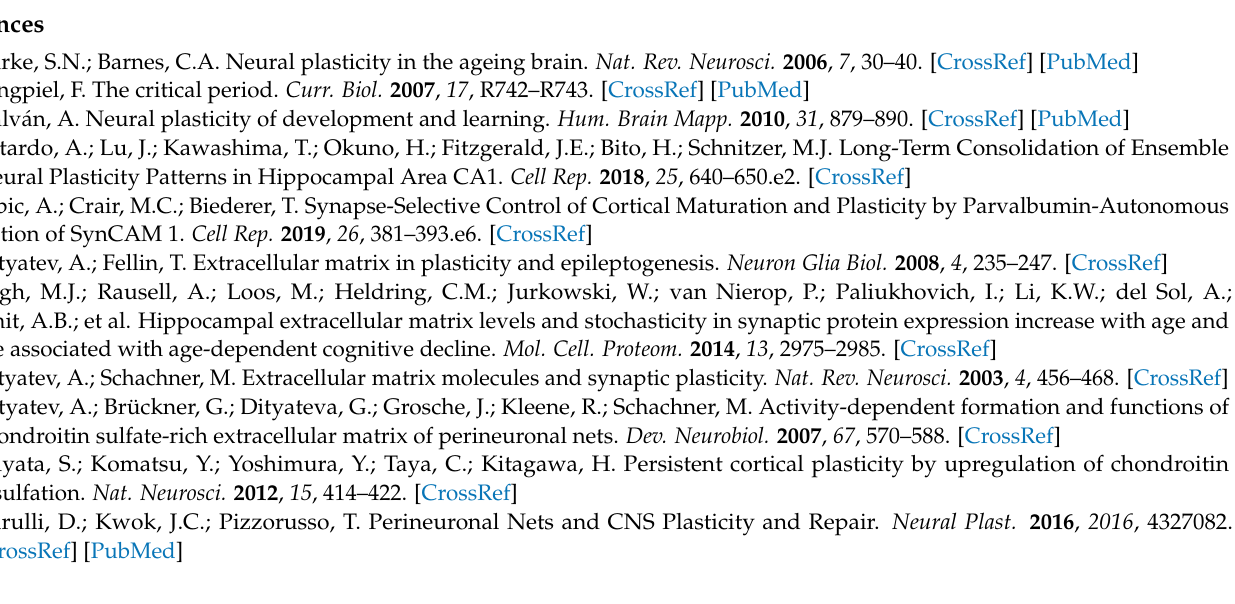
Table S2. Secondary antibodies and their dilutions. Figure S1. Downregulation of C6 sulfotransferase Chst3 in the hippocampus and cortex of 22-24 M-old mice; Figure S2. Impaired long-term NOLT memory in aged mice (22-24 M-old mice); Figure S3. Age-specific correlations in gene expression; Figure S4. Within and between age gene expression correlation patterns; Figure S5. Validation of CHST3 antibody specificity; Figure S6. Comparison of age-related dynamics of CHST3 expression in different regions of the human brain; Figure S7. Comparison of age-related dynamics of Chst3 expression in different mice